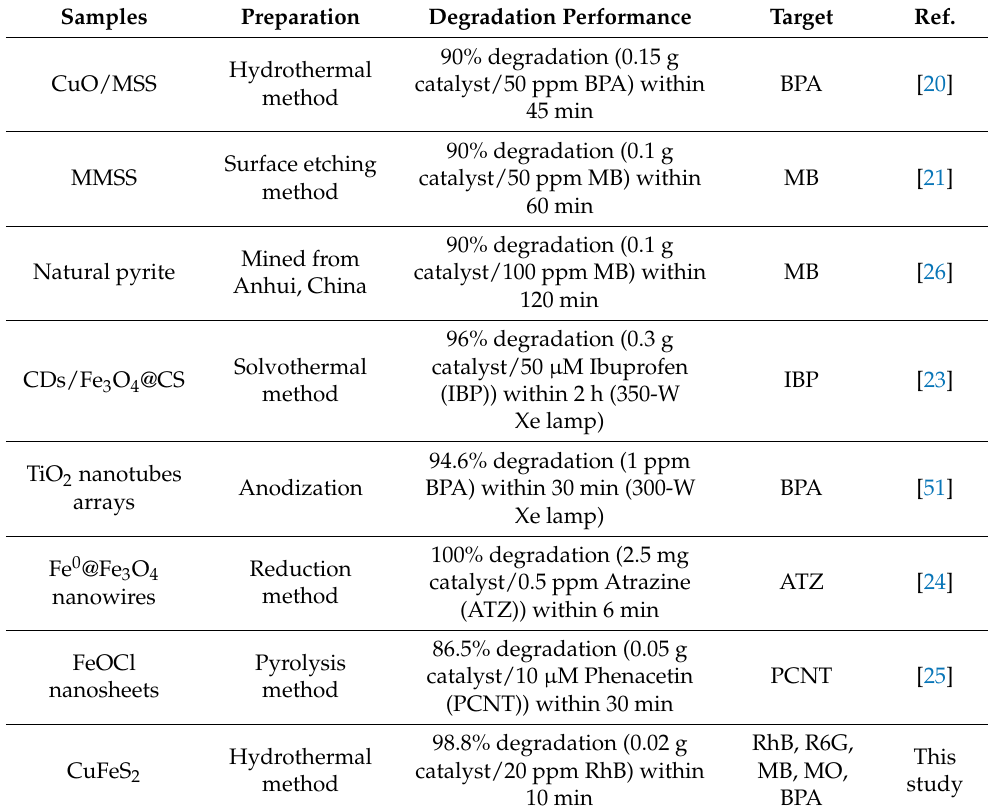
Table 1. Comparison of degradation performance using the (photo-) Fenton-like reaction.